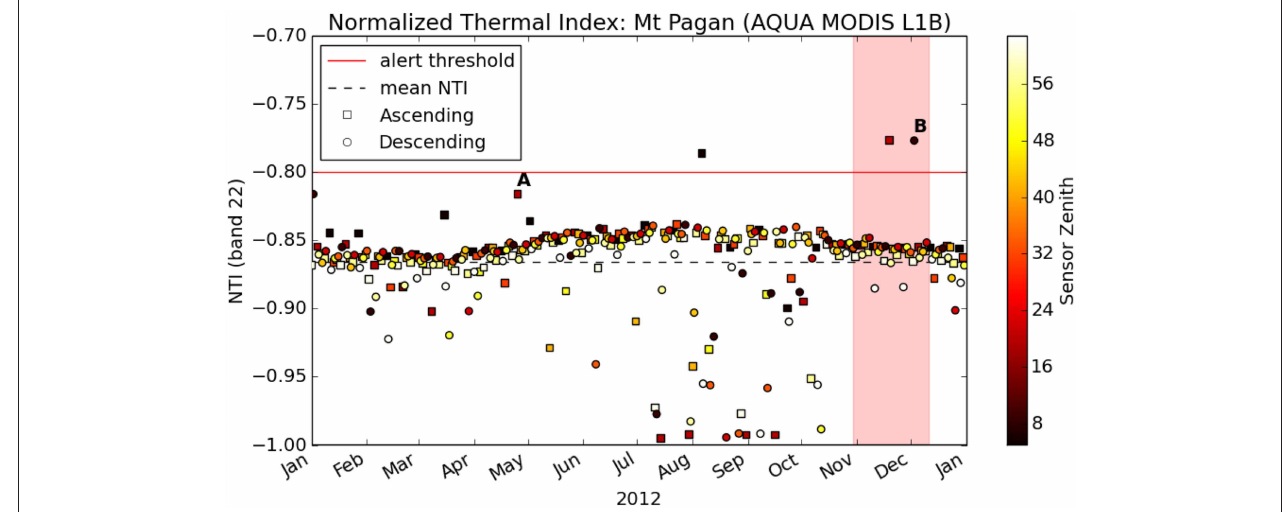
FIGURE 11 | Detailed subset of Figure 4 for 2012 showing Normalized Thermal Index as well as sensor viewing parameters. Square markers indicate ascending observations (looking east) and circles indicate descending observations (looking west). Markers are colored by sensor zenith angle (degrees from vertical). Note that only sensor zenith angles less than 1 ◦ have generated alerts. Label “A” corresponds to a near alert on 2012/04/25, and label “B” corresponds to alert on 2012/12/03 during the last eruptive phase of Mt. Pagan (see Figure 12 ).